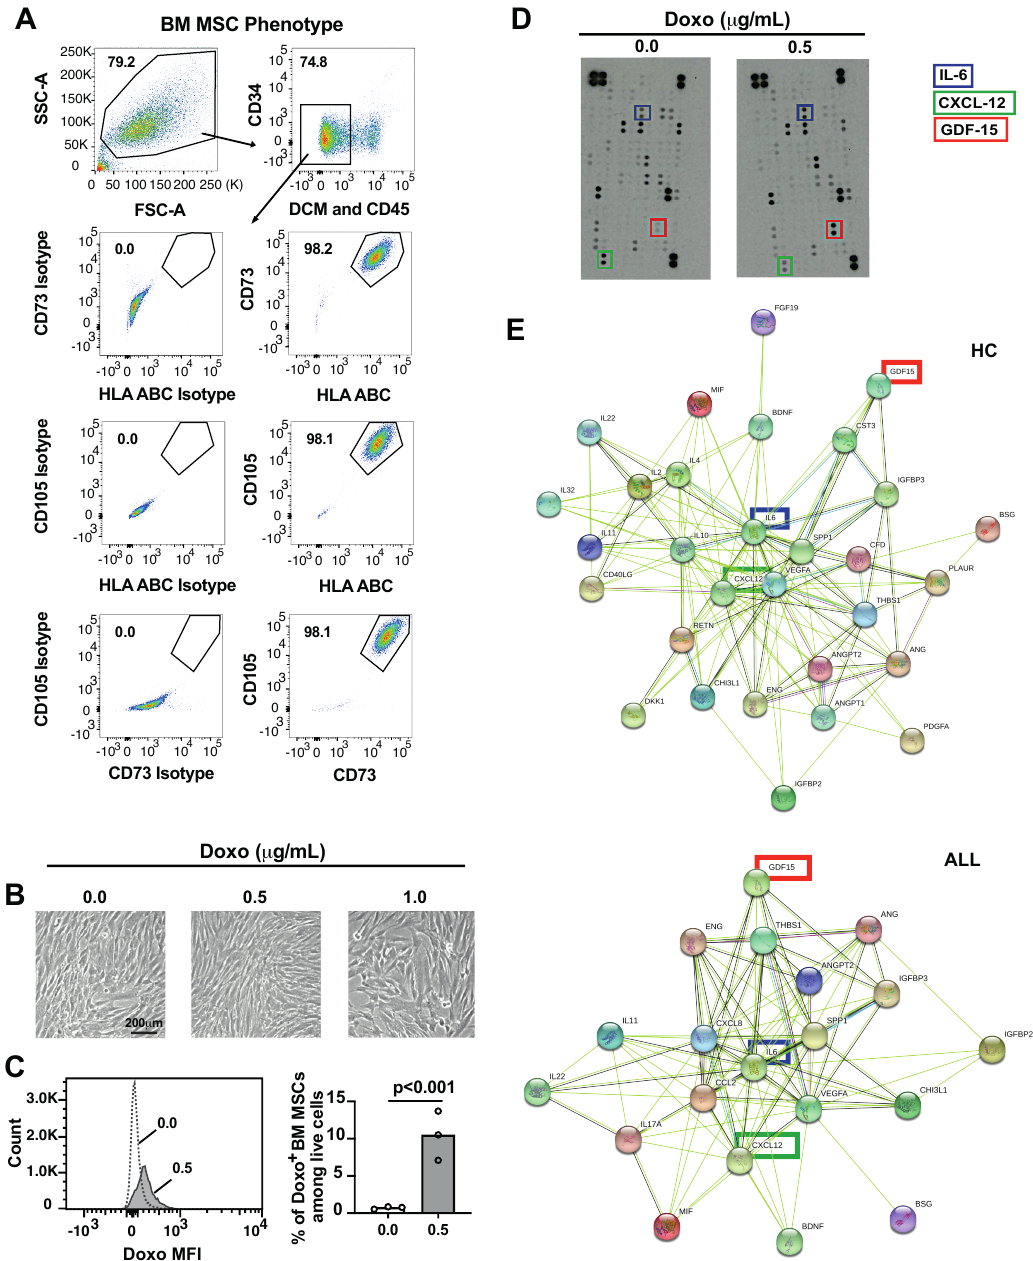
Figure 1. Primary human bone marrow (BM) mesenchymal stromal cell (MSC) characteristics following in vitro exposure to doxorubicin. ( A ) Representative gating-strategy of live (DCM – ) single BM MSCs defined as CD45 – and CD34 – and CD73 + , CD105 + and HLA-ABC + cells ahead of doxorubicin (Doxo) exposure (ALL donor). ( B ) Microscopy images of BM MSCs exposed to 0.0 µ g/mL, 0.5 µ g/mL or 1.0 µ g/mL Doxo, at 10 × magnification (Nikon Eclipse TS100 inverted). ( C ) Representative histogram on Doxo fluorescence intensity per Doxo + cell and compiled data of % Doxo + BM MSCs measured by flow cytometry ( n = 3, HC donors). ( D ) Representative picture of membranes displaying BM MSC expression of an array of cytokines and chemokines before (0.0 µ g/mL) and after (0.5 µ g/mL) Doxo exposure ( n = 3 HC and n = 3 ALL donors). Data from proteins that were differentially expressed after Doxo exposure were used for visualization of ( E ) protein–protein networks that were generated for each group (HC and ALL) separately. Nodes of the network are proteins indicated by their gene symbol, and edges are known protein–protein associations. Blue/purple edges are known interactions, while green/red edges are predicted interactions. Node colors are random and serve no particular